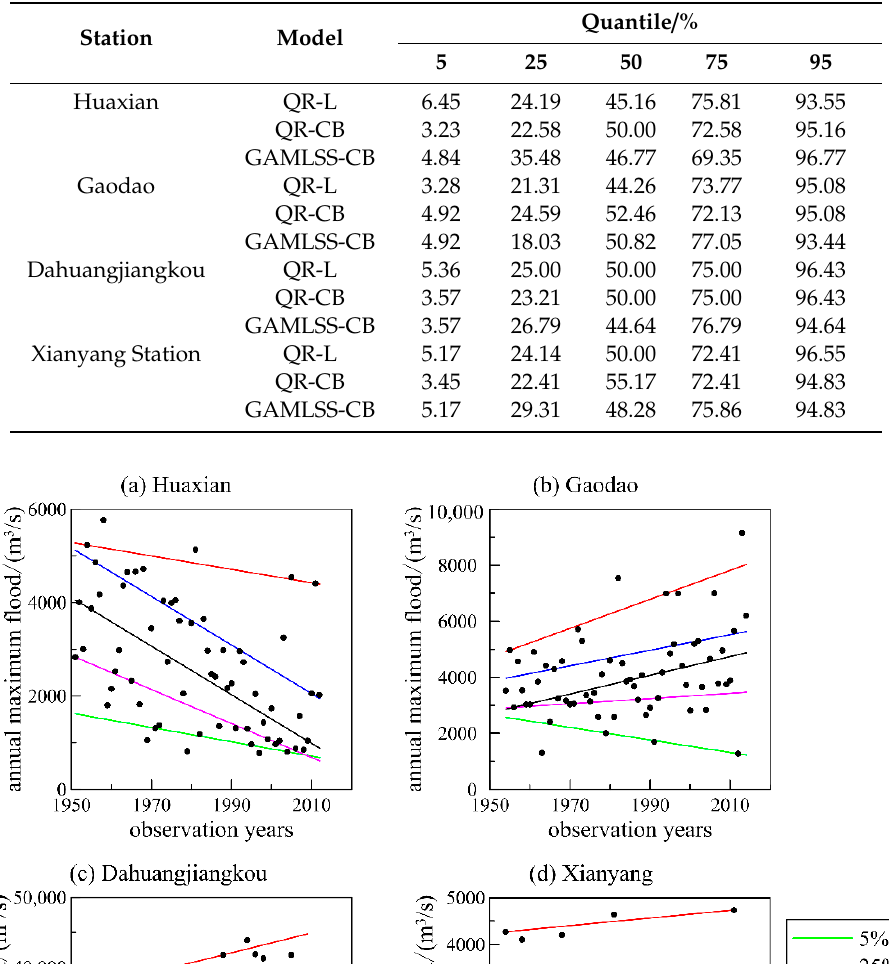
Table 4. Qualitative analysis of probability coverage of non-stationary models for each station.